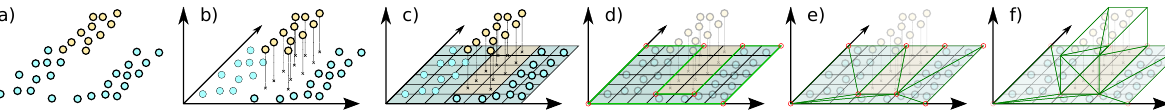
Figure 2. An overview of the geometric processing steps of the applied pipeline: Starting from a point cloud (a), the ground plane and corresponding coordinate system is found (b). Next, a height map of discreet height values is estimated (c). The boundaries of this height map are simplified (d) and a constrained Delaunay triangulation is used on the horizontal surfaces (e). Finally, the horizontal faces are displaced and the vertical faces are added